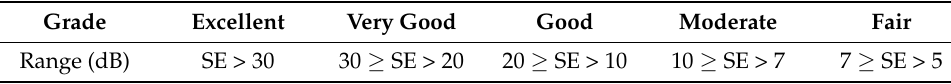
Table 5. Classification of EM SE values based on general